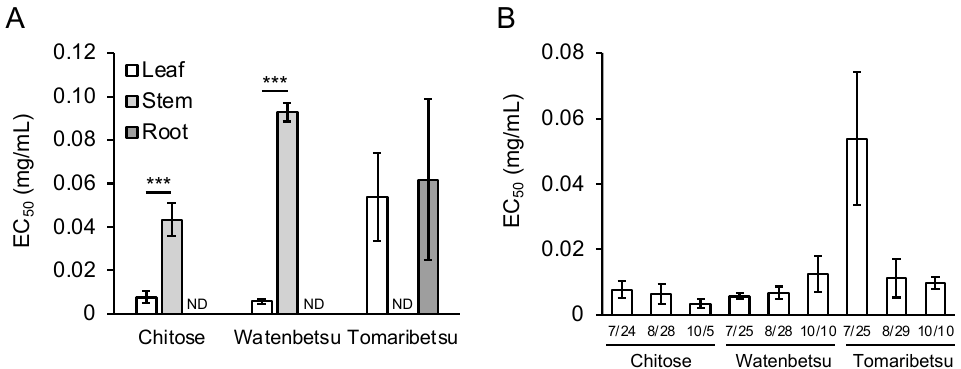
Figure 3. A β aggregation inhibitory activity of Perilla frutescens var. crispa leaves differed depending on fields and harvest time. ( A ) EC 50 in leaf, stem, and root extracts. Plants were cultivated in three fields in 2018 and harvested in late July. ( B ) The activity of Perilla frutescens var. crispa leaves was harvested in late July, late August, and early October. The activity was determined to be not detectable (ND) in samples if the inhibitory curve did not reach 50% of the percentage of SD values. Data are represented as mean ± SD ( n = 4 separate experiments). Comparison of EC 50 values (***: p < 0.005, Welch’s t -test).